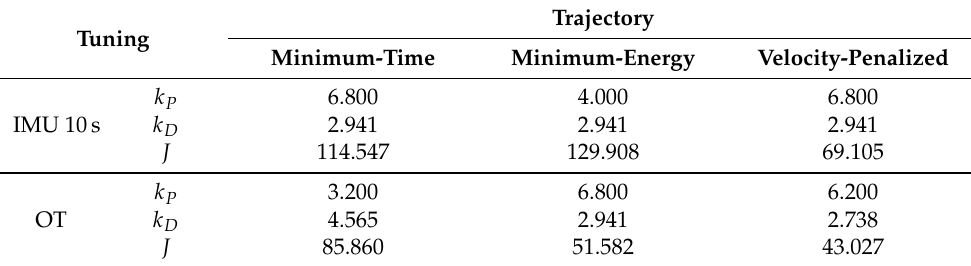
Table 4. Comparison of the obtained optimal